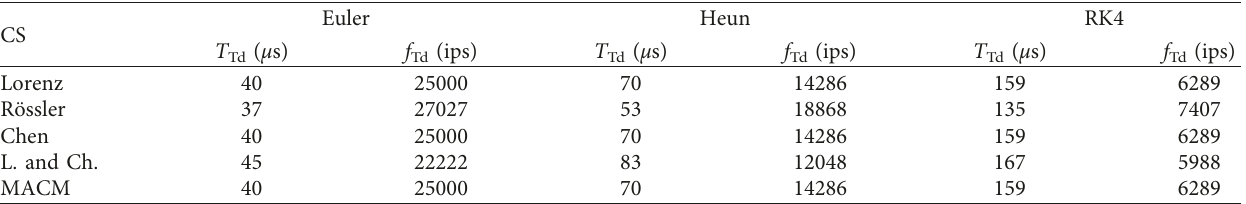
Table 10: Performance of ES in the V4 of the 3D Lorenz, R¨ossler, Chen, Liu and Chen, and MACM CSs in their DVs by using Euler (6), Heun (7) and (8), and RK4 (9)–(13) NAs.